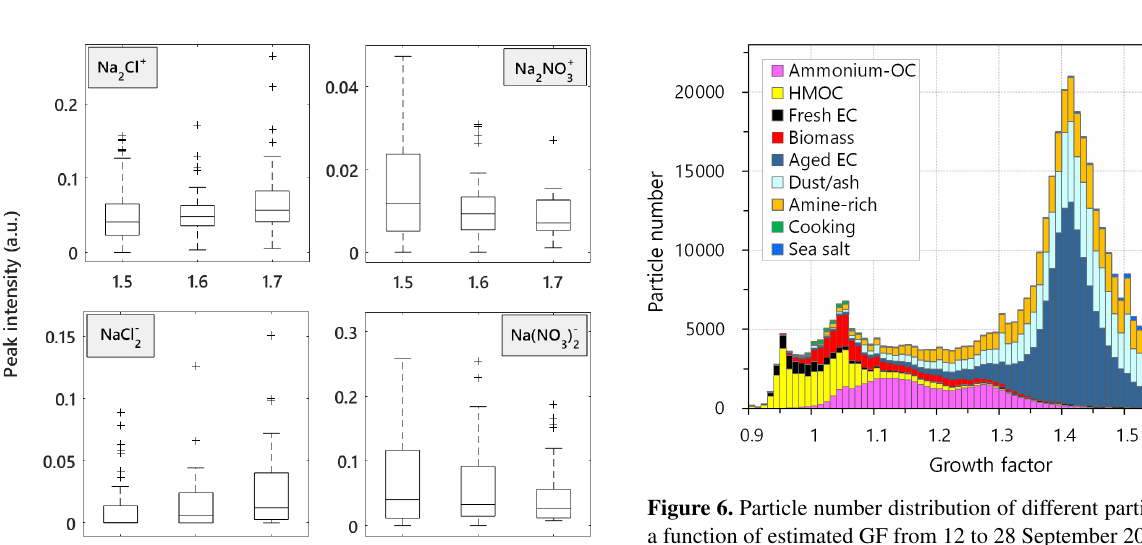
Figure 4. Statistics of nitrate and sulfate peak intensities (minimum, 25th percentile, median, 75th percentile, maximum) with GF in the HTDMA–ATOFMS experiment.